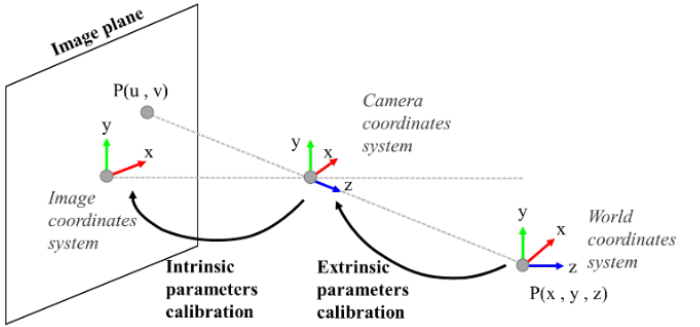
Figure 25. Transformation from world coordinate system to image coordinate system.